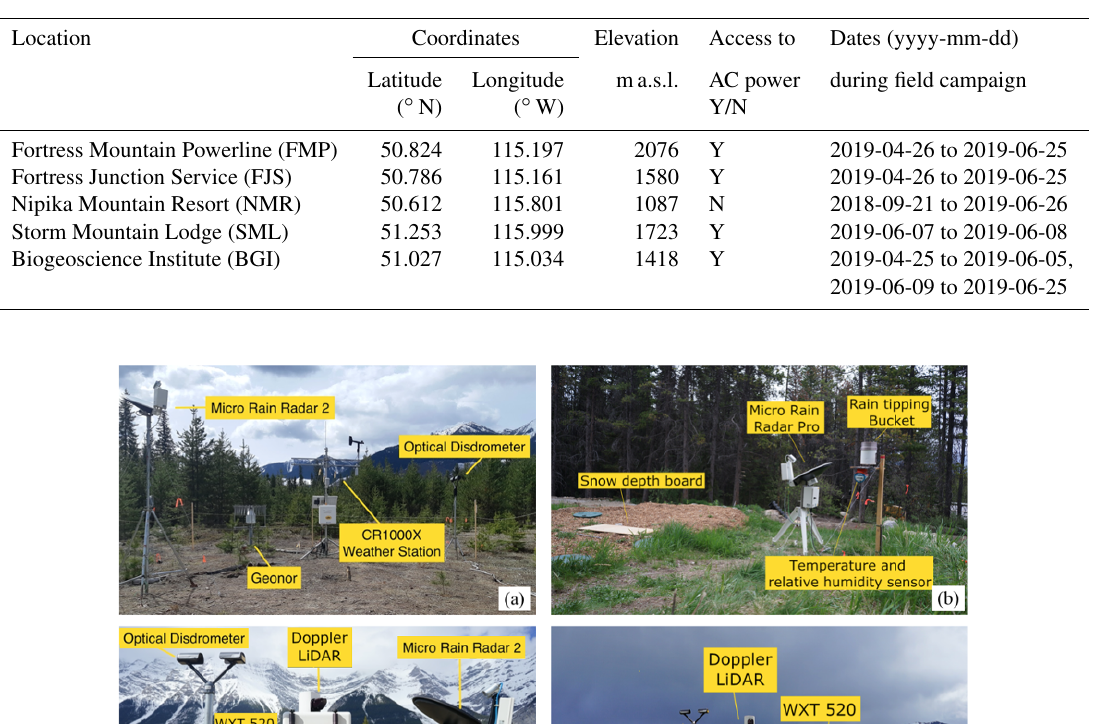
Table 1. A summary of the field sites that were used during the field campaign including information about their location, elevation, access to AC power, and dates that instruments were operational.